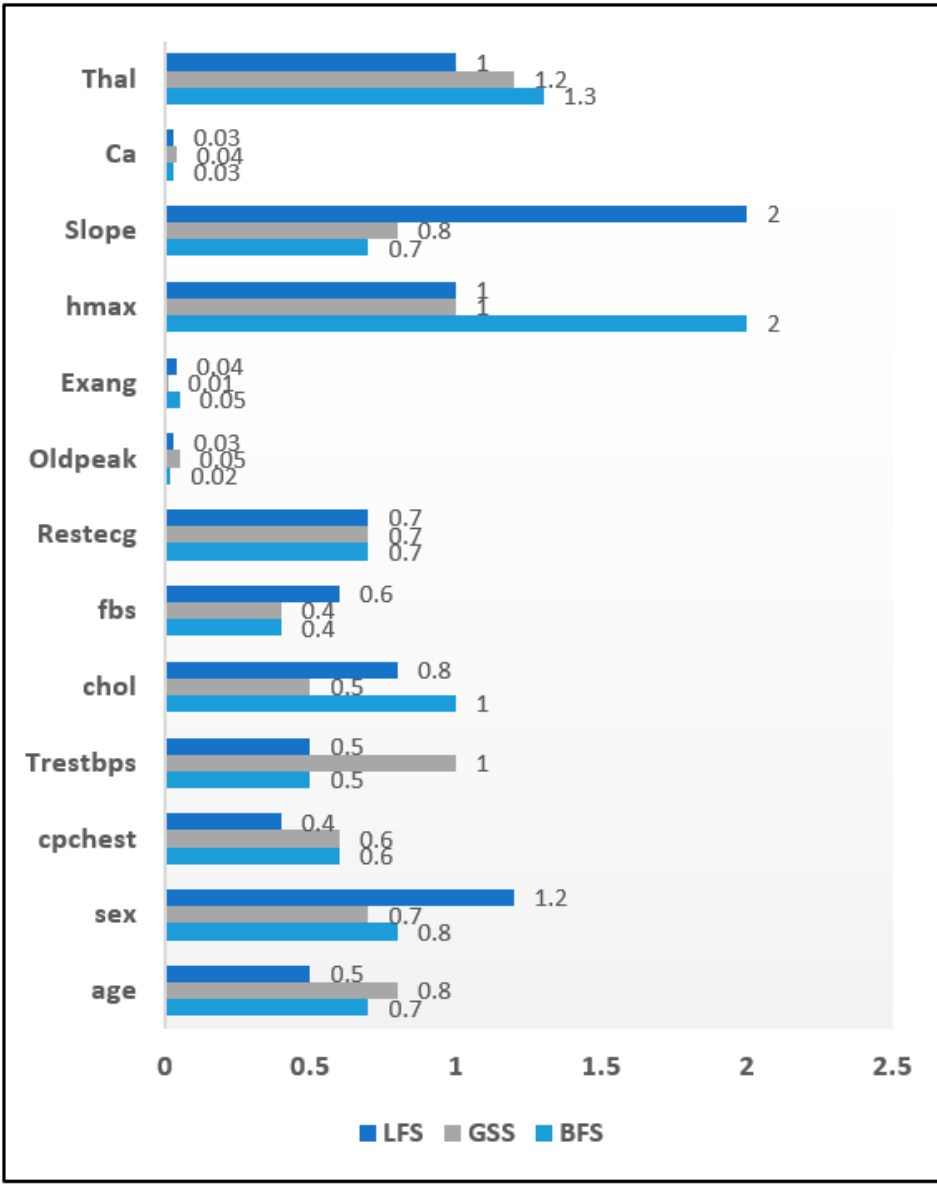
Figure 10. Attribute Significance Graph for the Diabetes dataset with Wrappers.